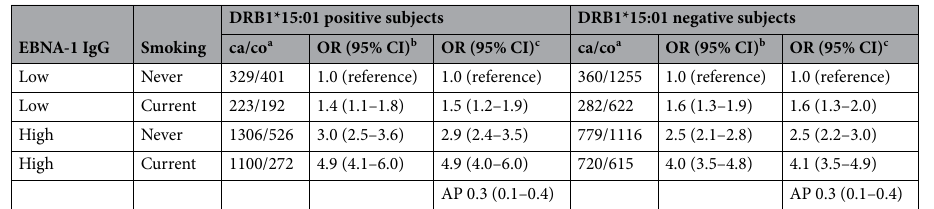
Table 4. OR with 95% CI of developing MS among subjects categorized by EBNA1 status and smoking, stratified by DRB1*15:01 status. AP with 95% CI between high EBNA1 IgG and smoking. a Number of exposed cases and controls b Adjusted for age, sex, residential area, study, and ancestry; c Adjusted for age, sex, residential area, study, ancestry, adolescent body mass index, past IM, DRB1*0301, DRB1*1303, DRB1*0801, A*0201, B*4402, B*3801, B*5501, DQA1*0101, DQB1*0302, DQB1*0301, homozygote correction for DRB1*1501,